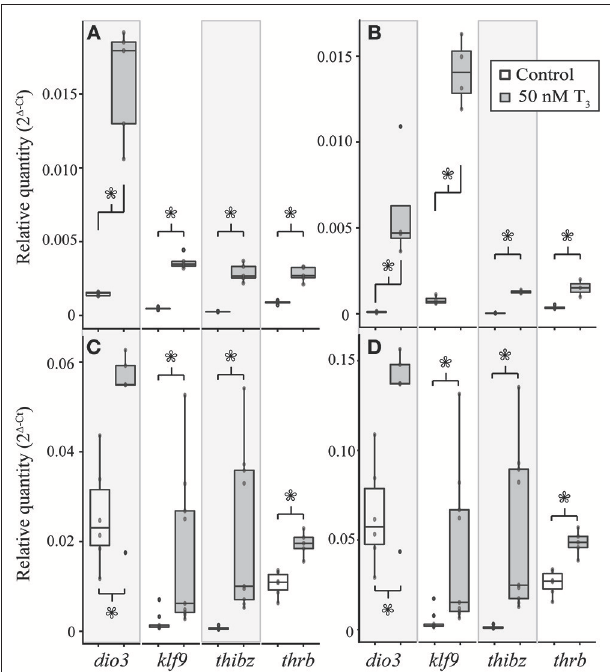
FIGURE 6 | Treatment with 50nM exogenous T 3 for 8h induces deiodinase type III ( dio3 ), krüppel-like factor 9 ( klf9 ), thyroid hormone induced bZip protein ( thibz ), and thrb expression in NF stage 52–54 X. tropicalis tail (A) and limb (B) explants and in TS stage 9 E. coqui tail (C) and limb explants (D) . Asterisks indicate a significant increase in mRNA levels (Student’s t -test, p < 0.05).